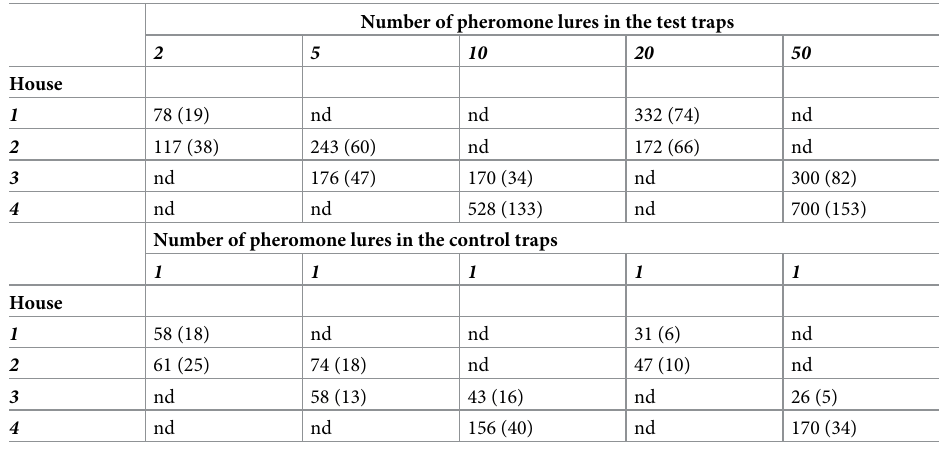
The number of lures placed in the test traps was either 2, 5, 10, 20 or 50 lures. 1 lure was placed in the control trap. nd indicates that a collection was not done.